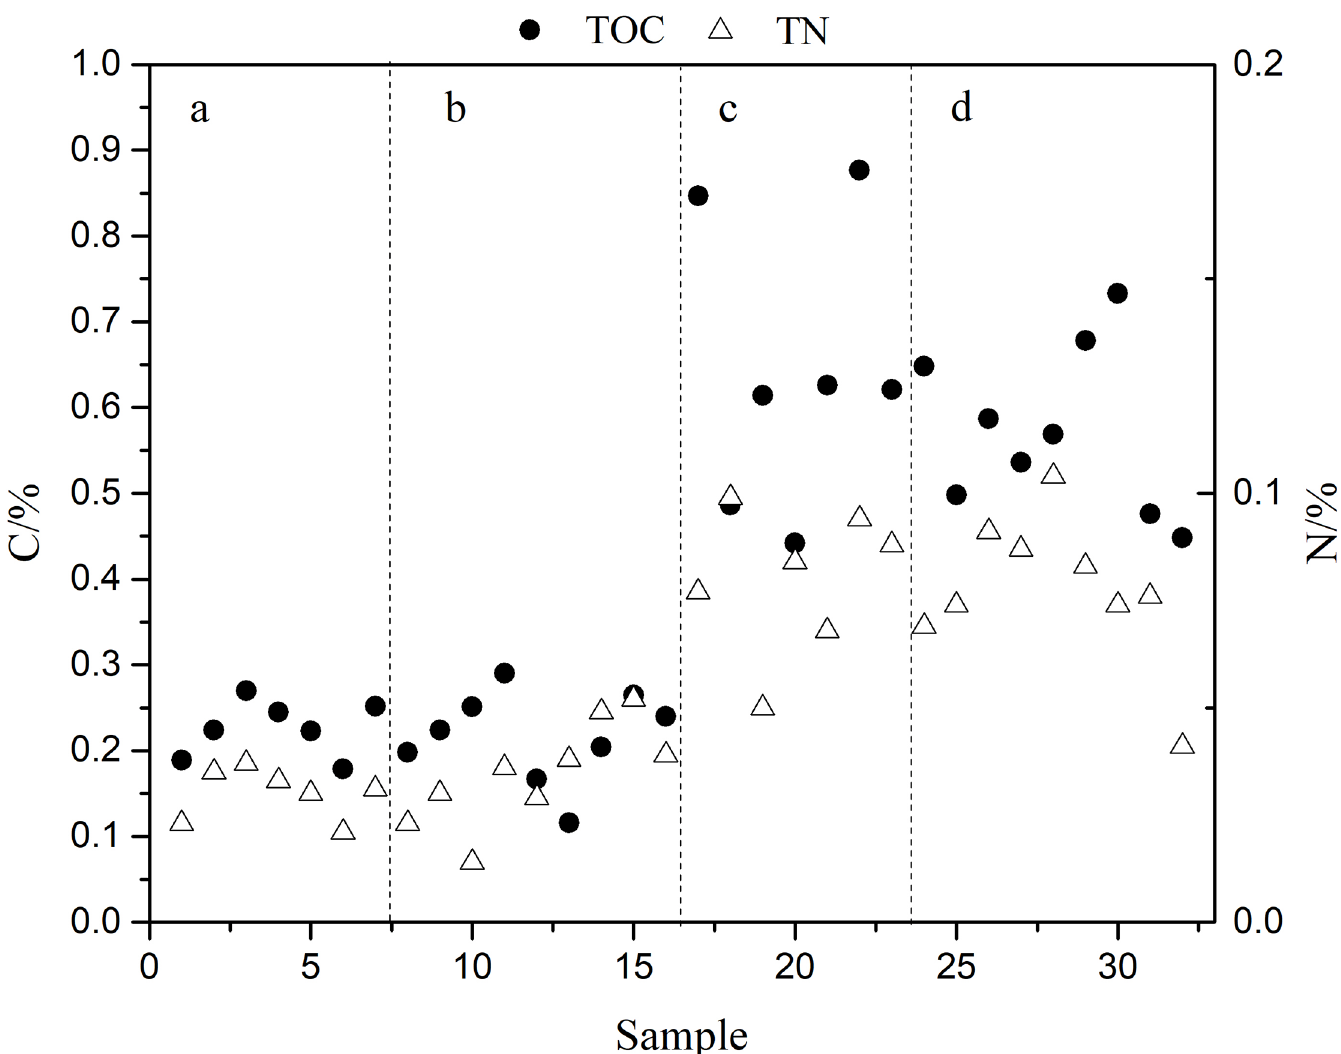
Fig 1. TOC and TN in the prepared silver phosphates which were purified by different methods in this study. (a) Soil samples treated by sodium hypochlorite. (b) Sediment samples treated by sodium hypochlorite. (c) Soil samples without treatment of sodium hypochlorite. (d) Sediment samples without treatment of sodium